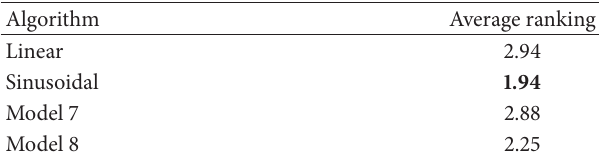
Table 2: Average algorithm rankings obtained by Friedman